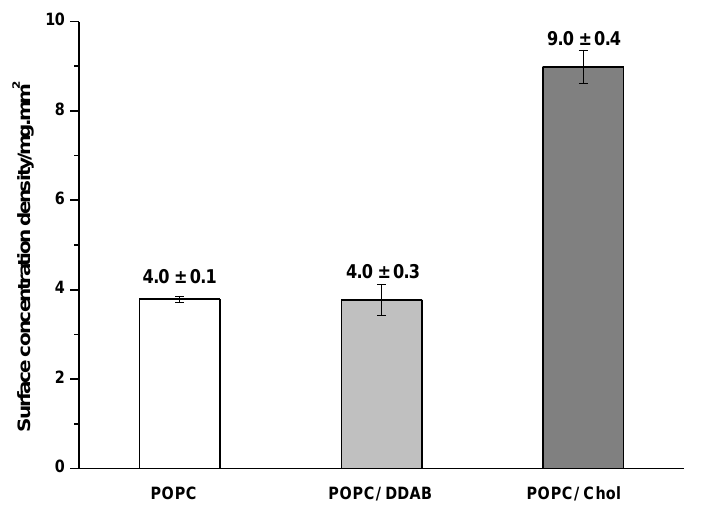
Figure 4. Surface concentration density of gold NPs adsorbed on the membrane of each composition after the SPRi assay was completed.